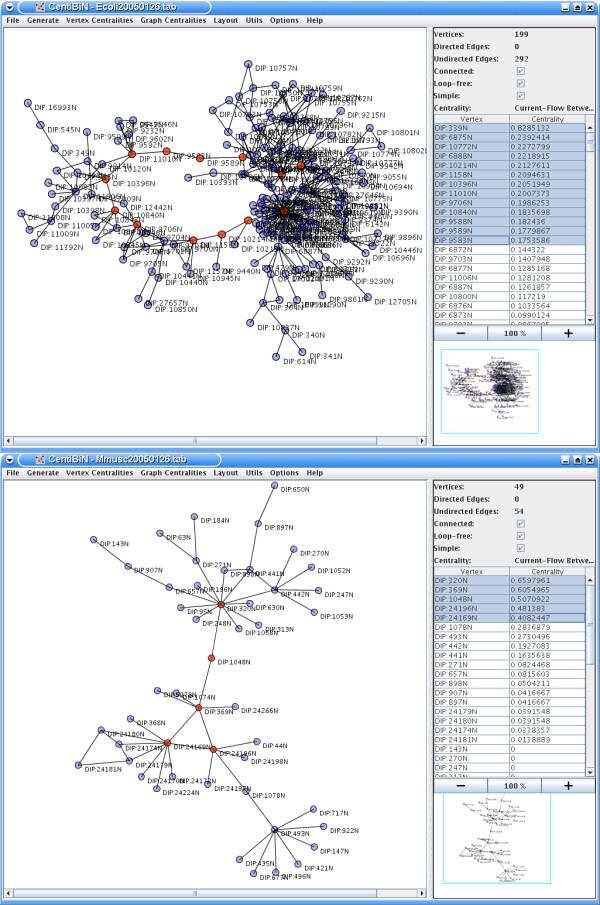
Two screen-shots showing centrality analysis with CentiBiN. The networks represent protein-protein interactions in Escherichia coli (top) and Mus musculus (bottom) according to the Database of Interacting Proteins (DIP), release 2005-01-26. The top ranking proteins according to the Current-Flow Betweenness centrality [21] are highlighted.